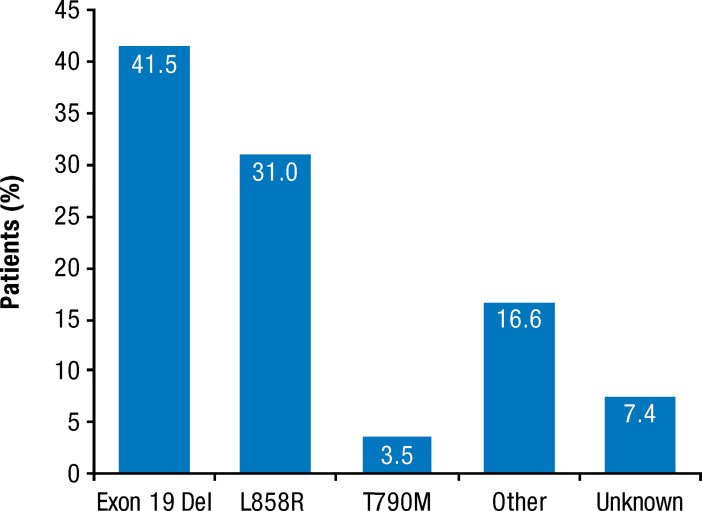
Frequency of the most common EGFR mutations (n = 2,080).